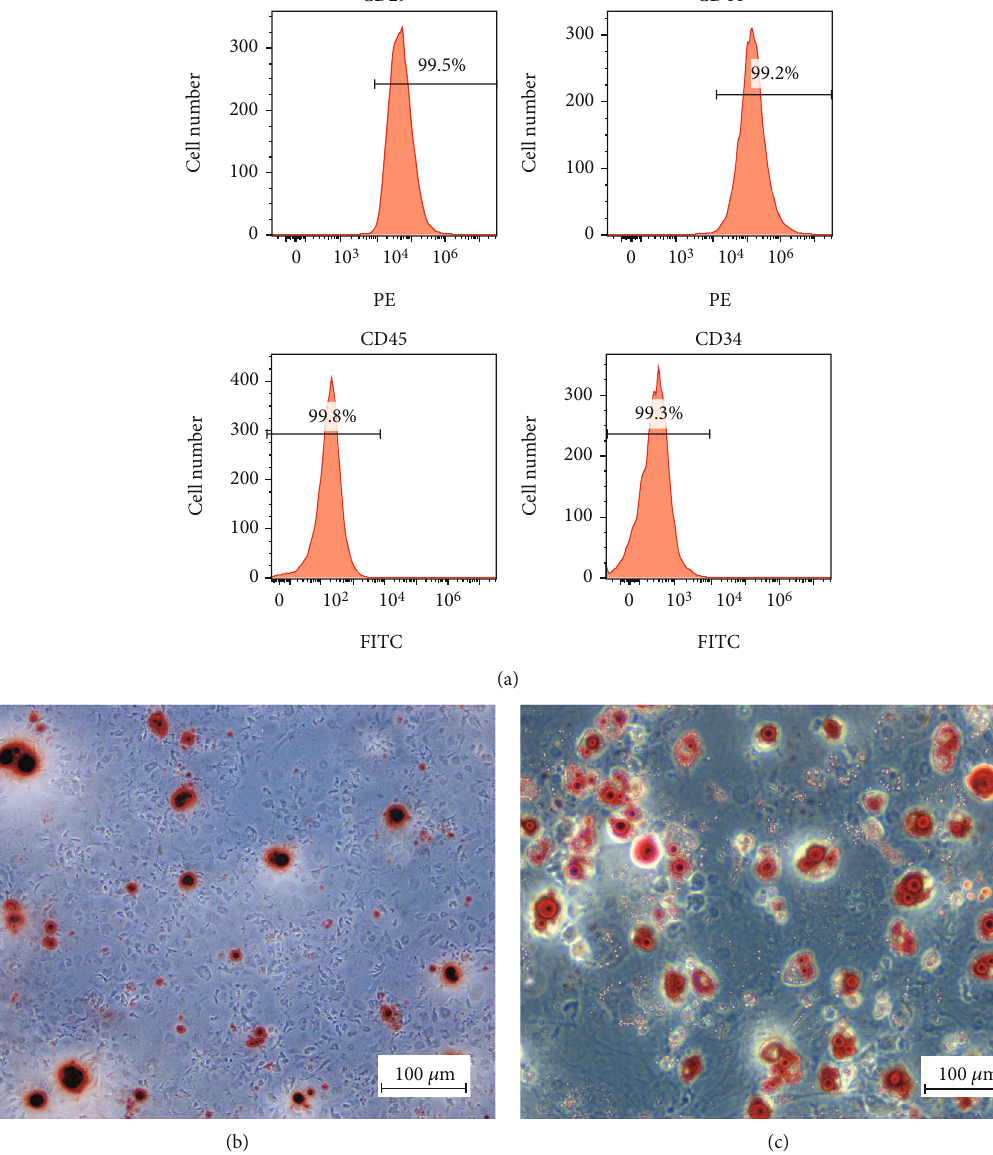
Figure 1: Identi fi cation of BMSCs. Cells were evaluated by surface markers and their multipotency to di ff erentiate. (a) Cells were stained with FITC- or PE-conjugated antibodies. The di ff erentiation of BMSCs using an induction medium induces cell di ff erentiation into osteocytes and adipocytes. The multipotency of BMSCs was con fi rmed as positive by alizarin red (b) and oil red O staining (c), indicating the di ff erentiation of BMSCs into osteocytes and adipocytes,